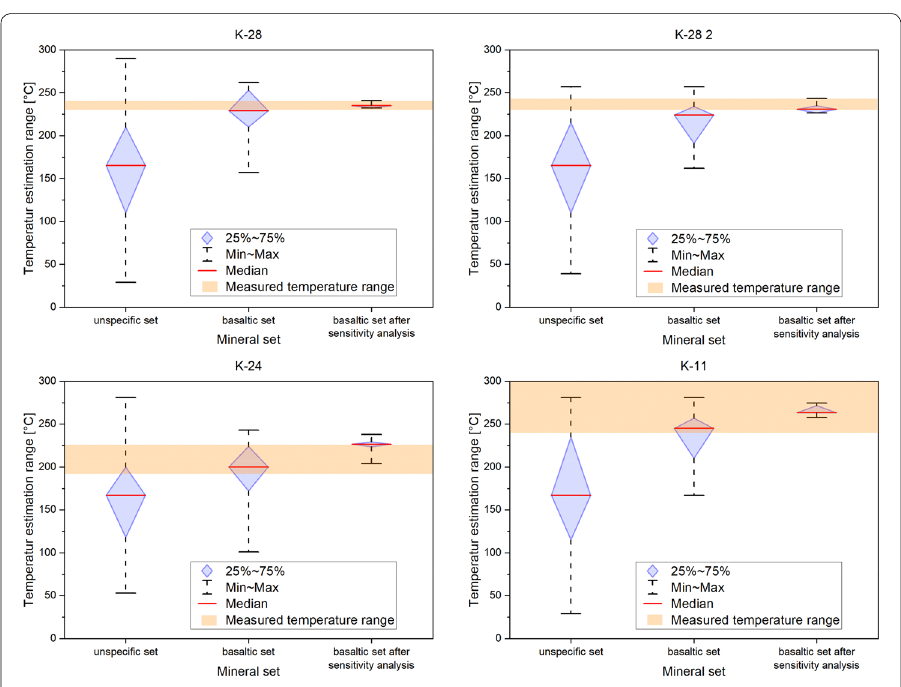
Fig. 7 Results of wells K-11, K-24, and K-28 for three stages of the analysis. The first column displays a temperature estimation calculated based on an unspecific mineral set. The box plot in the second column represents the specified basaltic mineral set. The last box plot shows the optimized temperature estimation via the pH, aluminium concentration, and steam loss sensitivity analysis. These box plots can be compared with the range of the measured temperatures in the boreholes, given by the orange